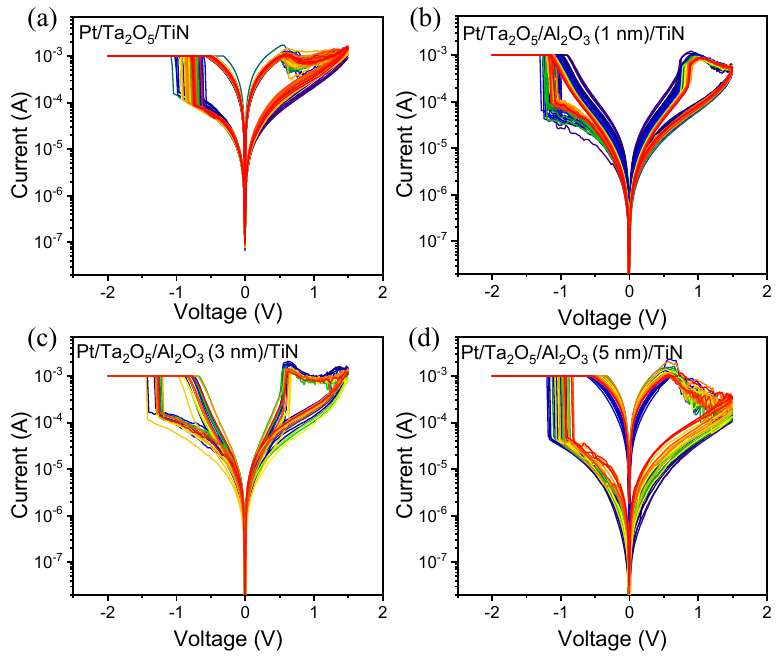
Figure 3. Experimental I – V results of ( a ) Pt/Ta 2 O 5 /TiN; ( b ) Pt/Ta 2 O 5 /Al 2 O 3 (1 nm)/TiN; ( c ) Pt/Ta 2 O 5 /Al 2 O 3 (3 nm)/TiN; ( d ) Pt/Ta 2 O 5 /Al 2 O 3 (5 nm)/TiN devices.